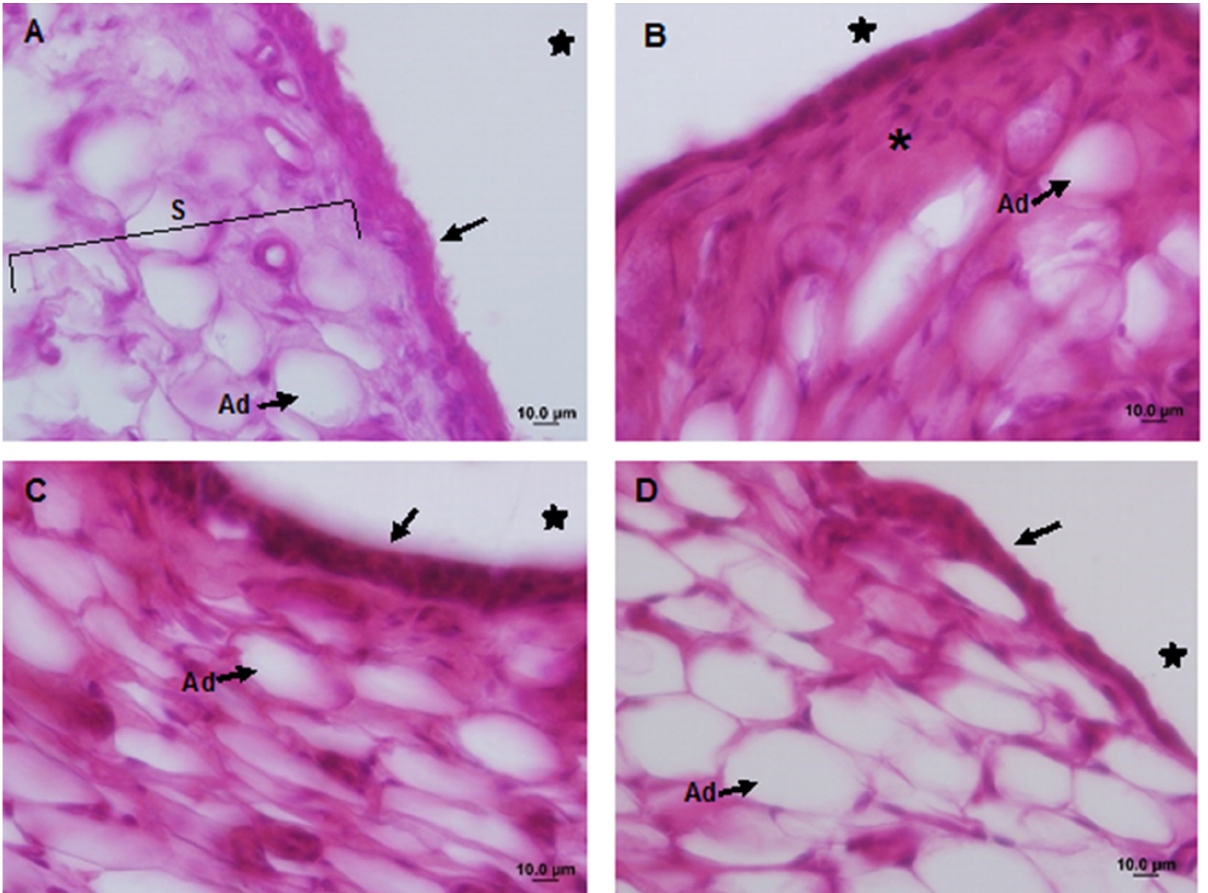
Fig 2: Photomicrographs of the synovial membrane of the ankle joint of Wistar rats. Sagittal section, hematoxylin and eosin staining. Control group (A), Lesion group (B), Exercise group (C) and Exercise and Lesion group (D). In A, membrane with thin synovial intima (black arrow) containing synoviocytes and subintima (S), with a predominance of adipose cells (Ad). In B, thickening of the synovial membrane, which is discretely fibrous (asterisk) with less adipocytes (Ad). In C and D, synovial membrane with the intima showing normal appearance (black arrow), with a predominance of adipose cells (Ad) in the subintima. Articular cavity